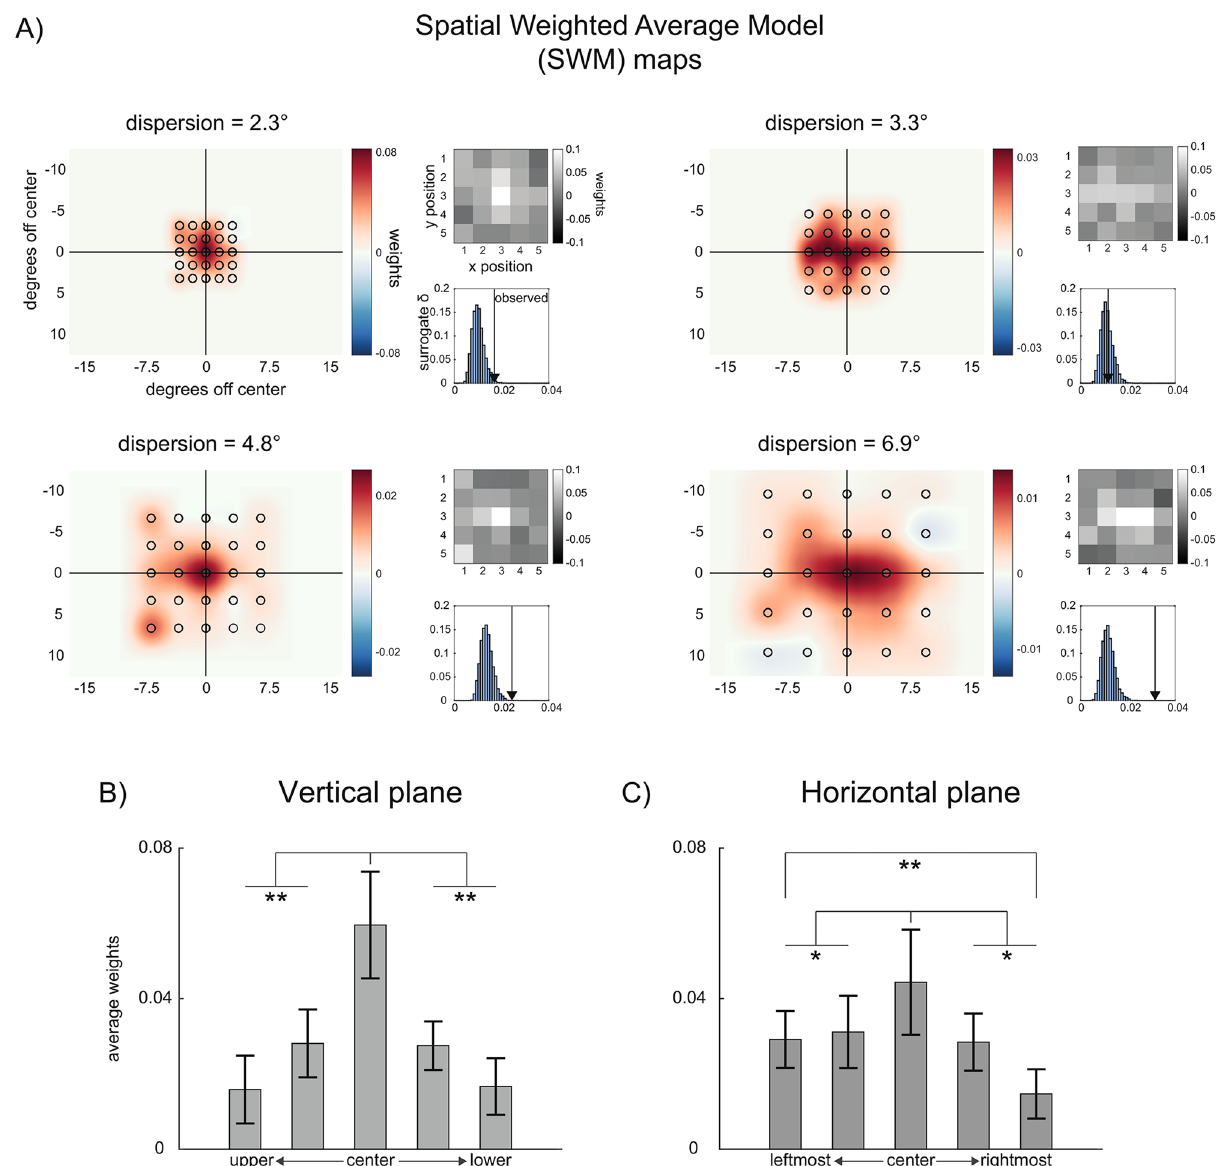
Figure 2. Results of Experiment 1. ( A ) SWM maps for each dispersion condition. Grey-scale maps visualize the original weights in matrix coordinates, estimated through the spatial weighted averaging model. Red and blue maps are the corresponding smoothed heatmaps, in screen coordinates. Histograms show the results of the permutation statistic, comparing the observed distance of weights ( δ ) from a uniform distribution (black arrow) to that of randomly permuted surrogate maps (blue bars). ( B ) Comparison of weights along the vertical plane, collapsing columns of SWM maps. ( C ) Comparison of weights along the horizontal plane, collapsing rows of SWM maps. Error bars correspond to the standard deviation of the mean. * = p < 0.05; ** = p < on its location and dispersion in the visual field (Fig. 2A). The distribution of weights within ensembles deviated significantly from a theoretical uniform distribution, as evident in three out of four dispersion levels (all p < 0.01, except for dispersion = 3.33°, p = 0.37; permutation statistics). To test whether the observed anisotropies were statistically different across dispersion levels, we compared the distribution of weights in the four conditions using the permutation F-statistic (see “General methods” sec- tion). This analysis revealed no significant difference in the distribution of weights across dispersion levels (all p > 0.05). Thus, the presence of systematic spatial anisotropies was independent of the dispersion of disks in the visual field. To further characterize the nature of these biases, we collapsed across dispersion levels and com- pared weights assigned to disks along the vertical and horizontal plane. This revealed a bias toward the center and left-hand side of the ensemble (center vs. lower and upper locations: t (31) = 4.17, p < 0.001, d ′ = 0.74, Fig. 2B; center vs. left-side and right-side locations: t (31) = 2.12, p = 0.04, d ′ = 0.37; leftmost column vs. rightmost column: t (31) = 3.25, p = 0.003, d ′ = 0.57; all other p > 0.05; paired t-tests, Fig. 2C).